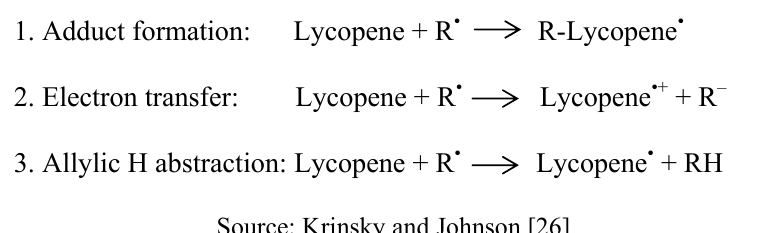
Figure 3. Three Possible Reactions of Carotenoids with Radical Species (R •